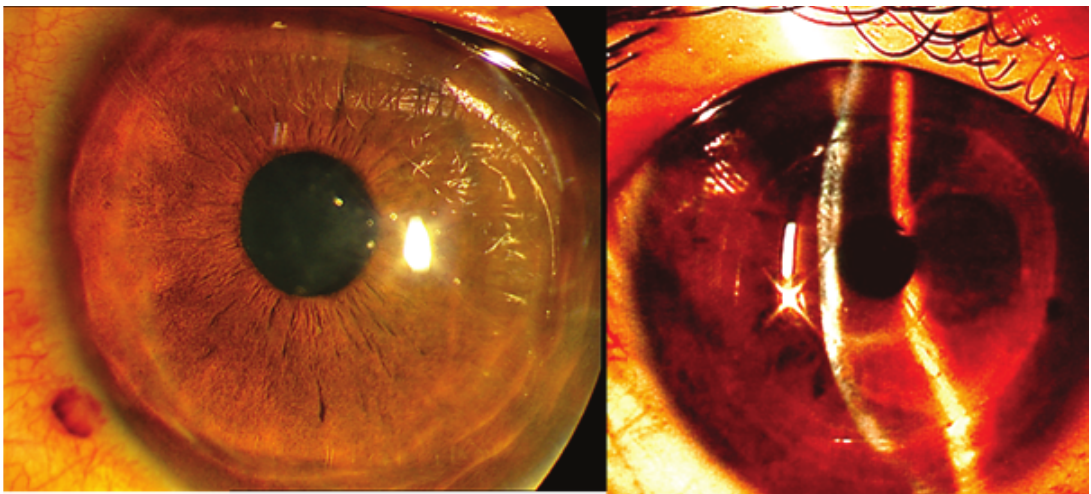
Figure 1. Slit photo of case number 5, 51 months after FASK shows mild haziness and wrinkling of interface.